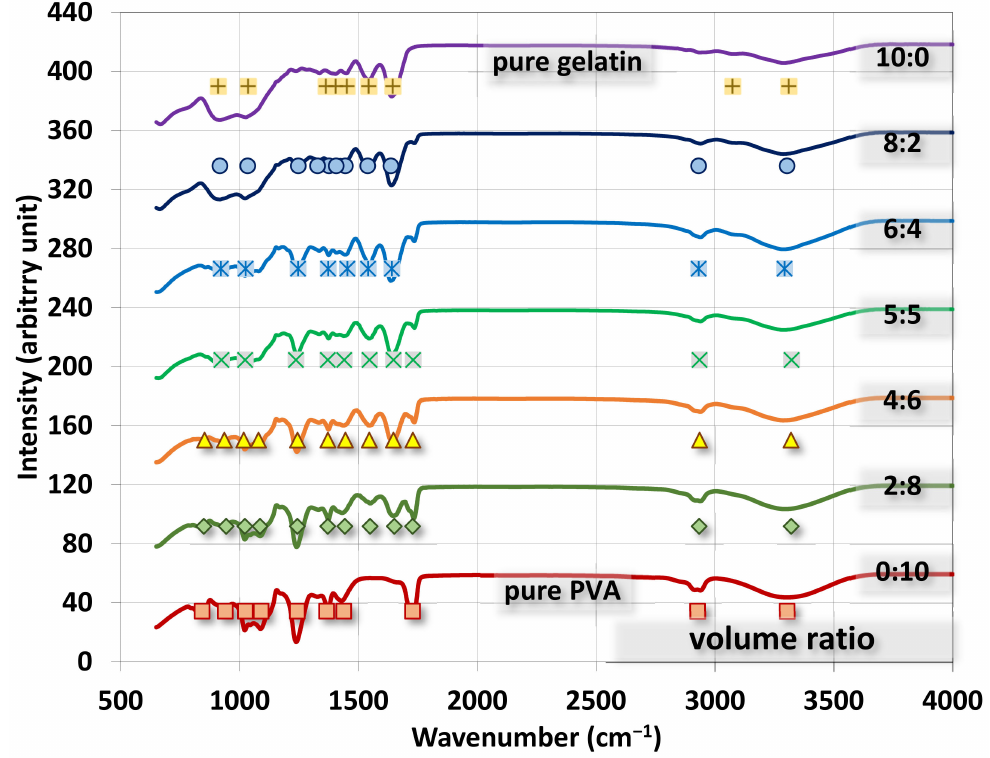
Figure 9. FTIR spectra for electrospun gelatin/PVA nanofiber films with different volumetric mixing